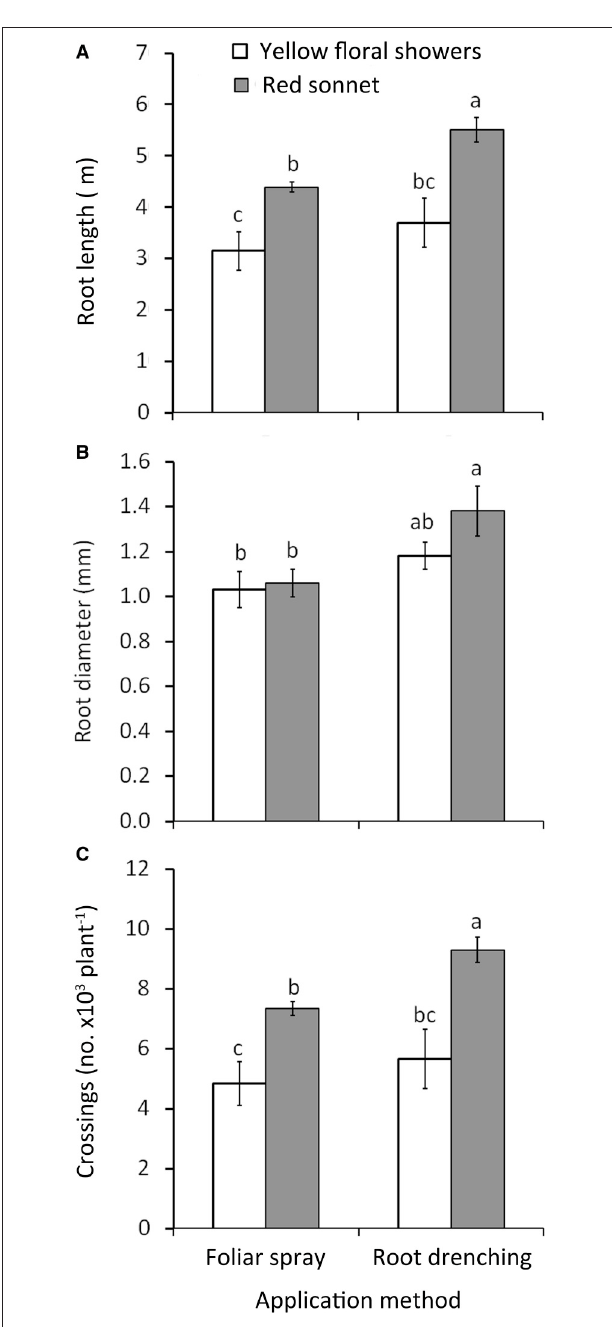
FIGURE 3 | Effect of biostimulant application method (F, foliar spray; R, root drenching) and cultivar (“Yellow floral shower” and “Red sonnet”) on root length (A) , root diameter (B), and crossing number (C) at the end of the experiment (166 DAT). Vertical bars (standard error) ( n = 9) with different letters are significantly different according to Duncan’s test ( P = 0.05).